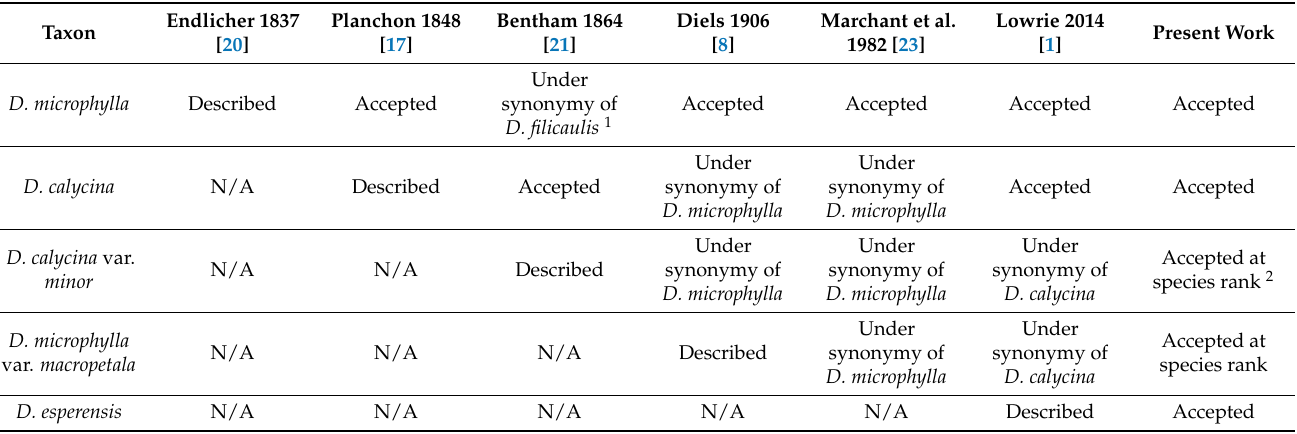
Table 1. Taxonomic history of the Drosera microphylla complex. N/A=taxon not yet described by the date of the